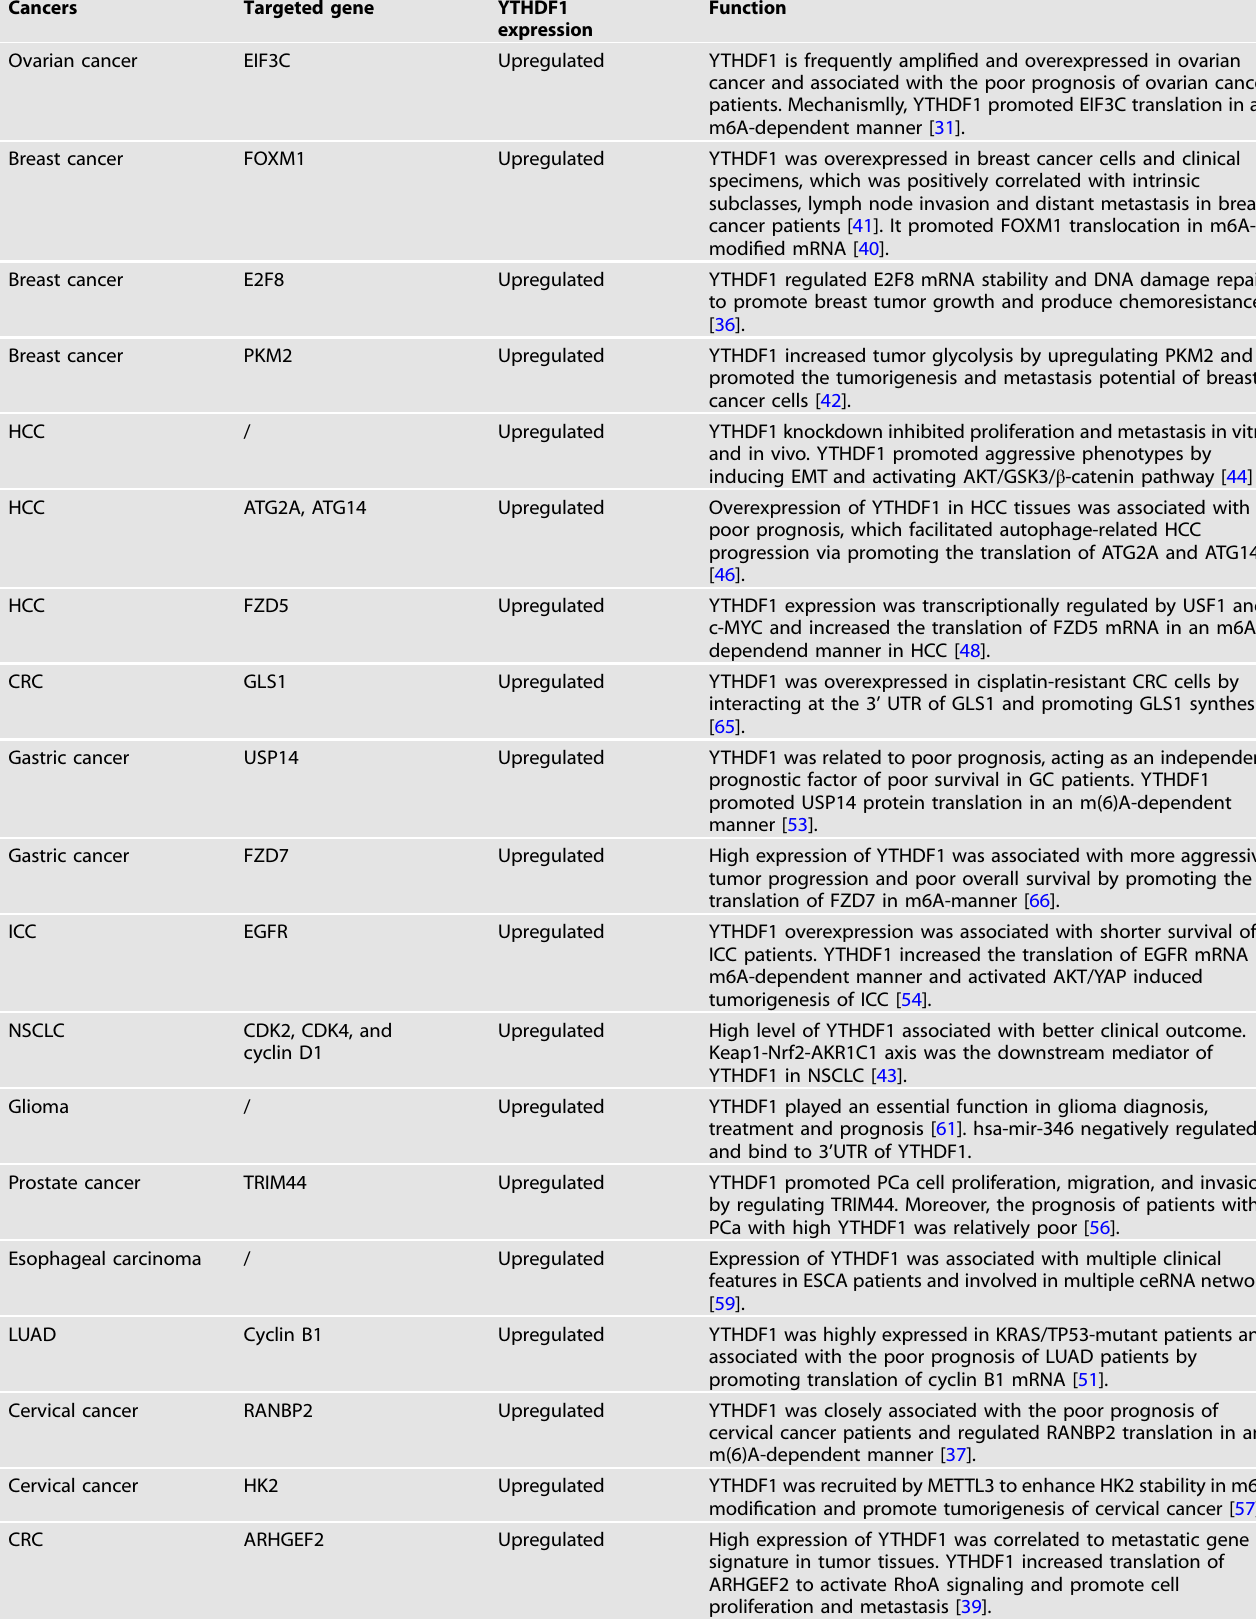
Table 3. YTHDF1 works as diagnostic biomarker and therapeutic target in patients with